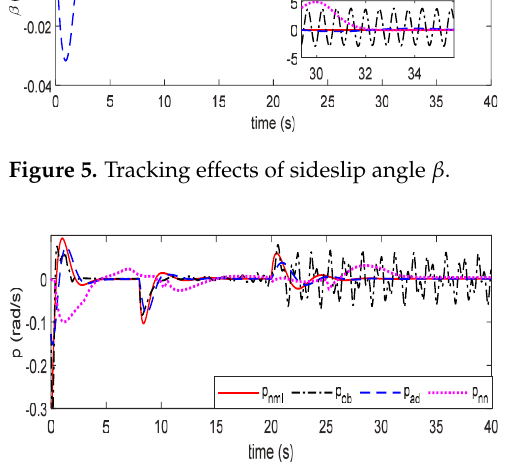
Figure 6. Tracking effects of roll rate p .